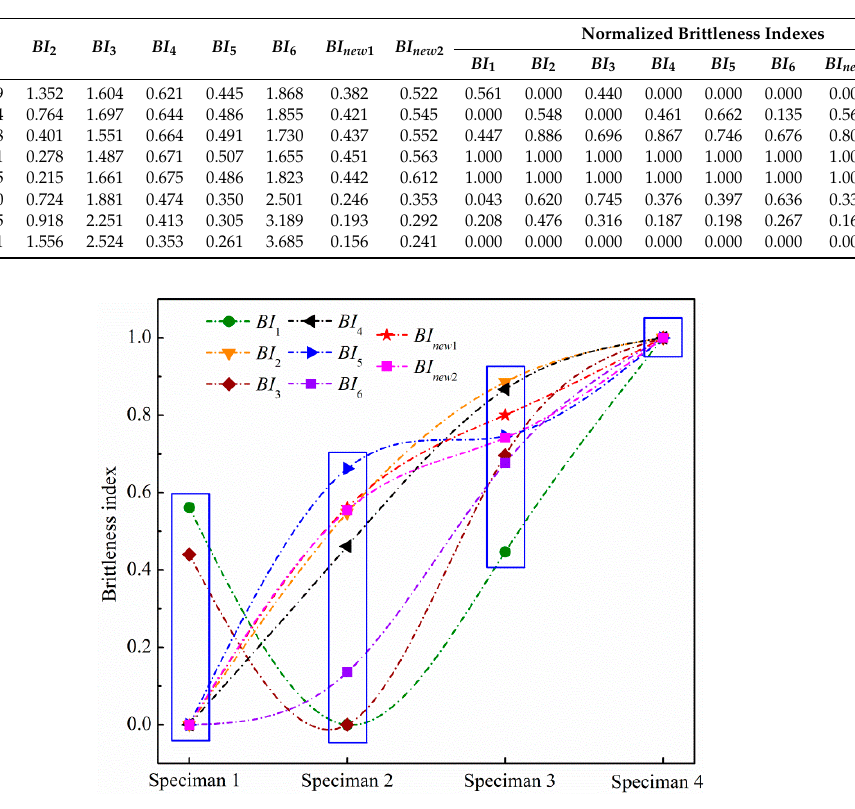
Figure 8. Normalized brittleness indexes of glutenite specimens under uniaxial compression.